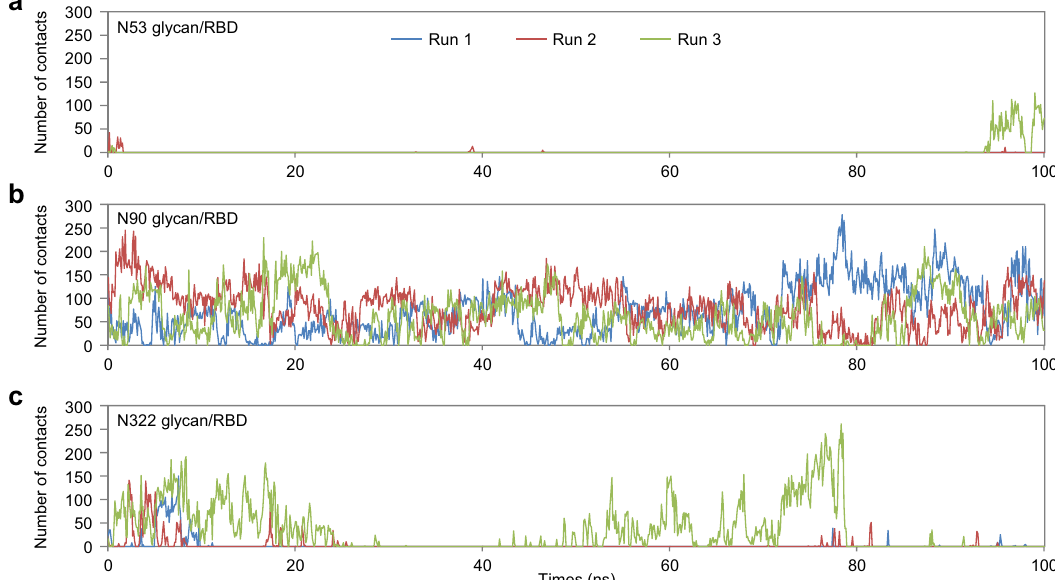
Fig. 6 ACE2 glycan contacts in the ACE2-RBD complex. Time trace of the number of contacts between ACE2 glycans at N53 ( a ), N90 ( b ), and N322 ( c ) and S-RBD residues in three simulation